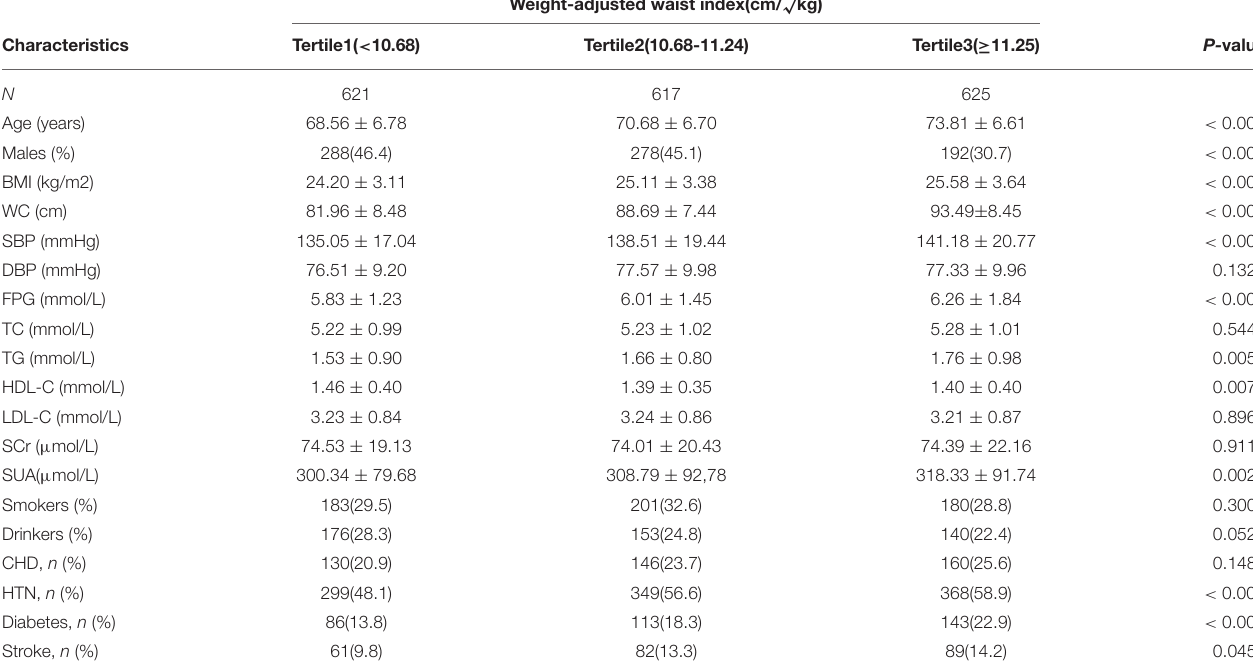
TABLE 1 | Baseline characteristics of study participants by weight-adjusted waist index.